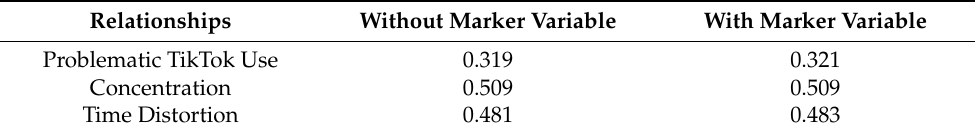
Table 2. Comparison of R 2 values between baseline model and marker-included model.